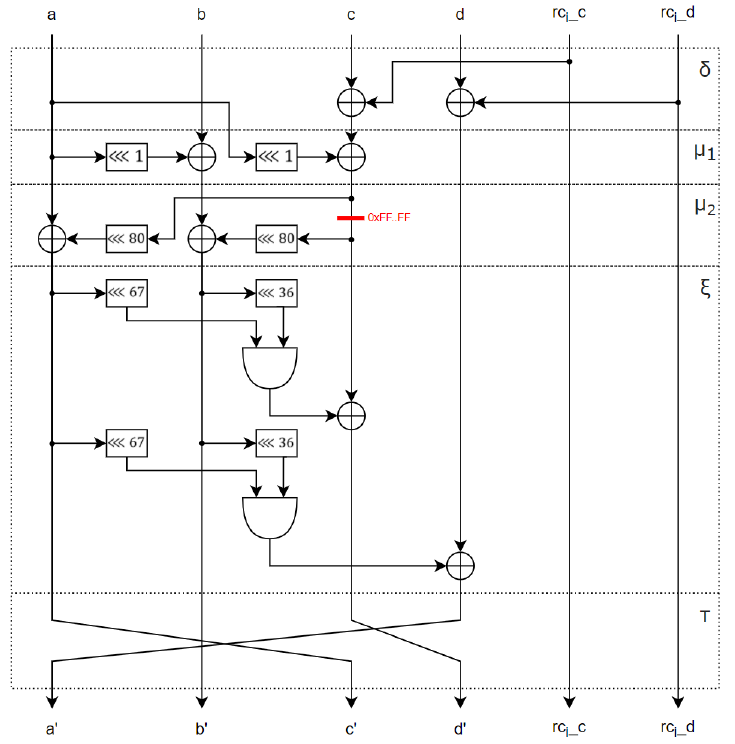
Figure 4. Round of